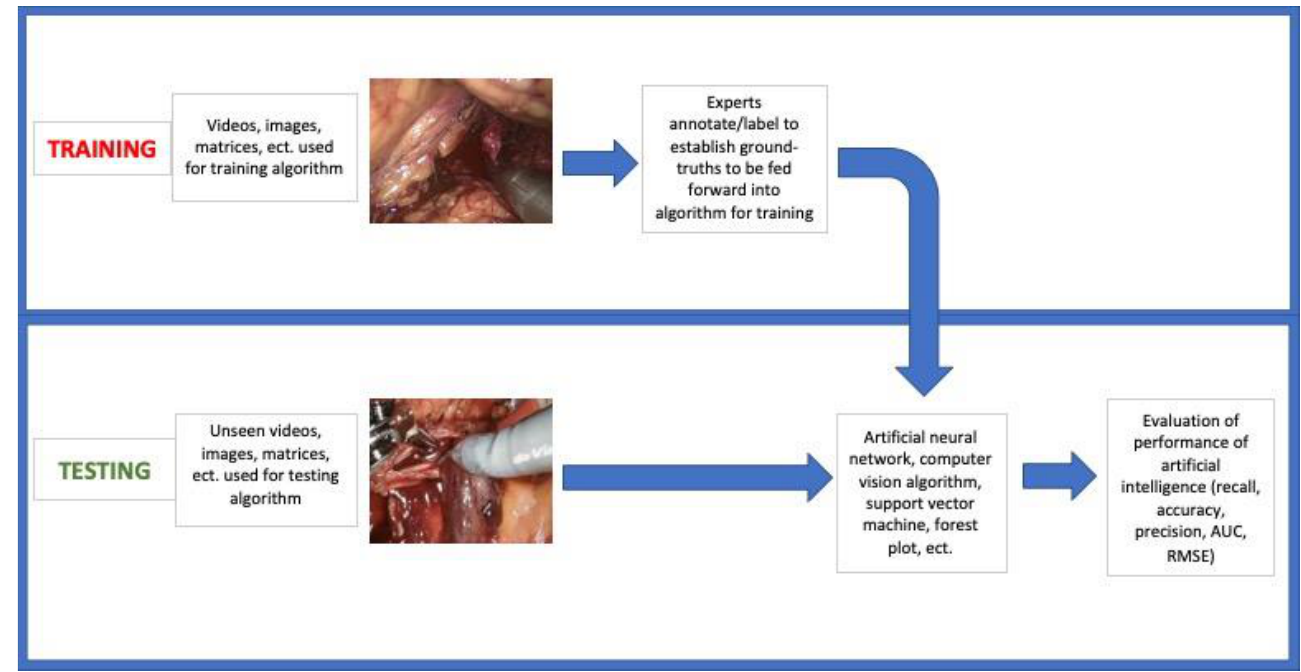
Figure 5. Flow-chart depicting methods of included articles, generally applicable to all included studies. AUC area under curve, RMSE root – mean square